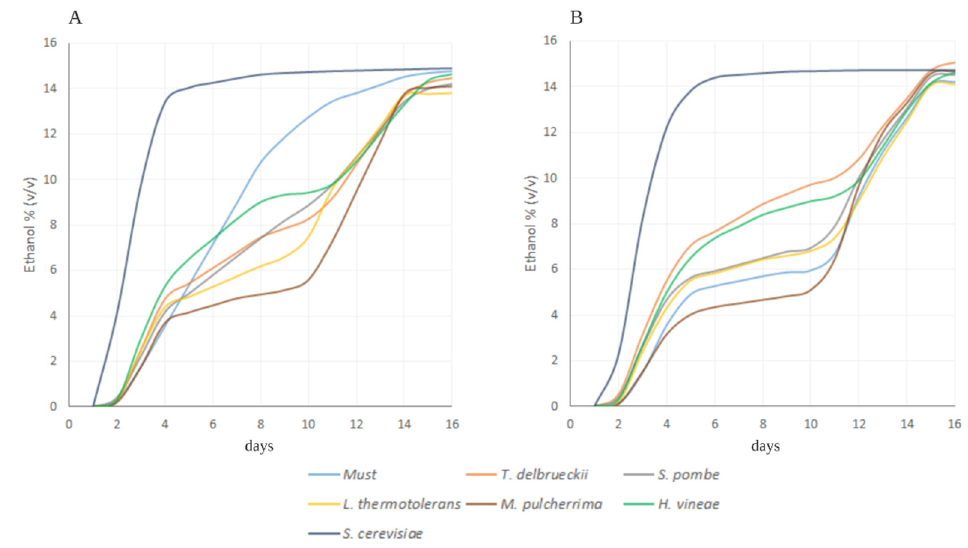
Figure 3. Kinetics of the alcoholic fermentation as a percentage of the estimated ethanol produced (% v/v ) after the 2nd inoculation (sequential inoculation). ( A ) Vinifications from untreated grapes; ( B ) vinifications from PL-treated grapes.